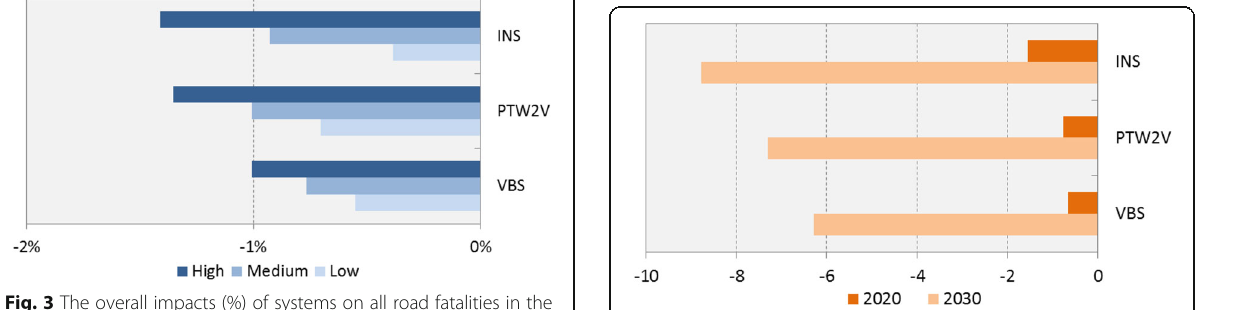
Fig. 5 The overall medium impact in number of PTW rider fatalities in the EU-28, future